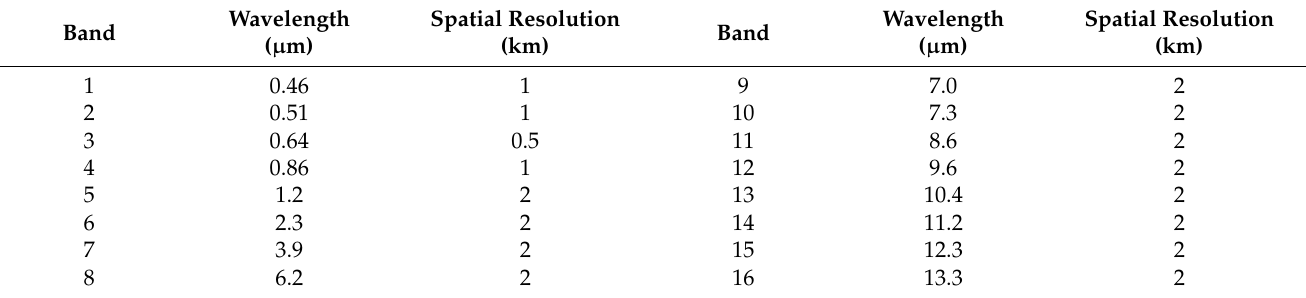
Table 2. Bands and spatial resolutions of